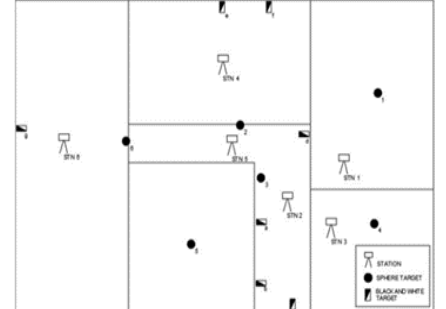
Figure 4: Position of the targets and laser scanner during data collection process.